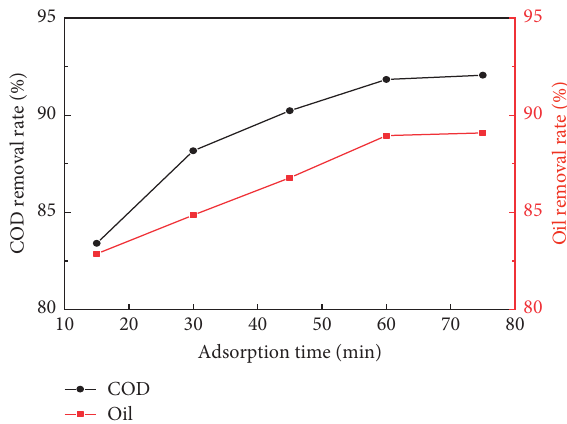
Figure 2: Influence of adsorption time on COD and oil removal rate in oilfield wastewater.